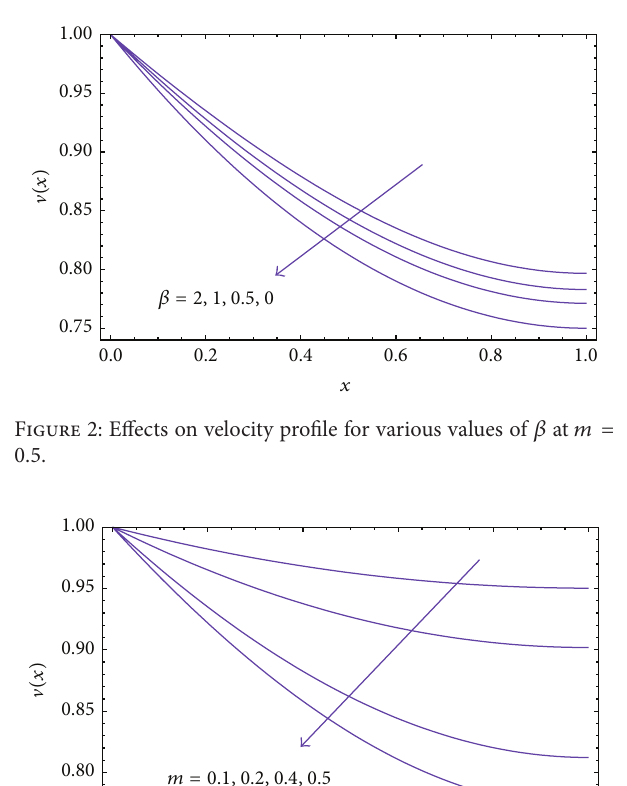
results are obtained for the problem. The results are sketched and discussed for the fluid parameter 𝛽 and for constant 𝑚